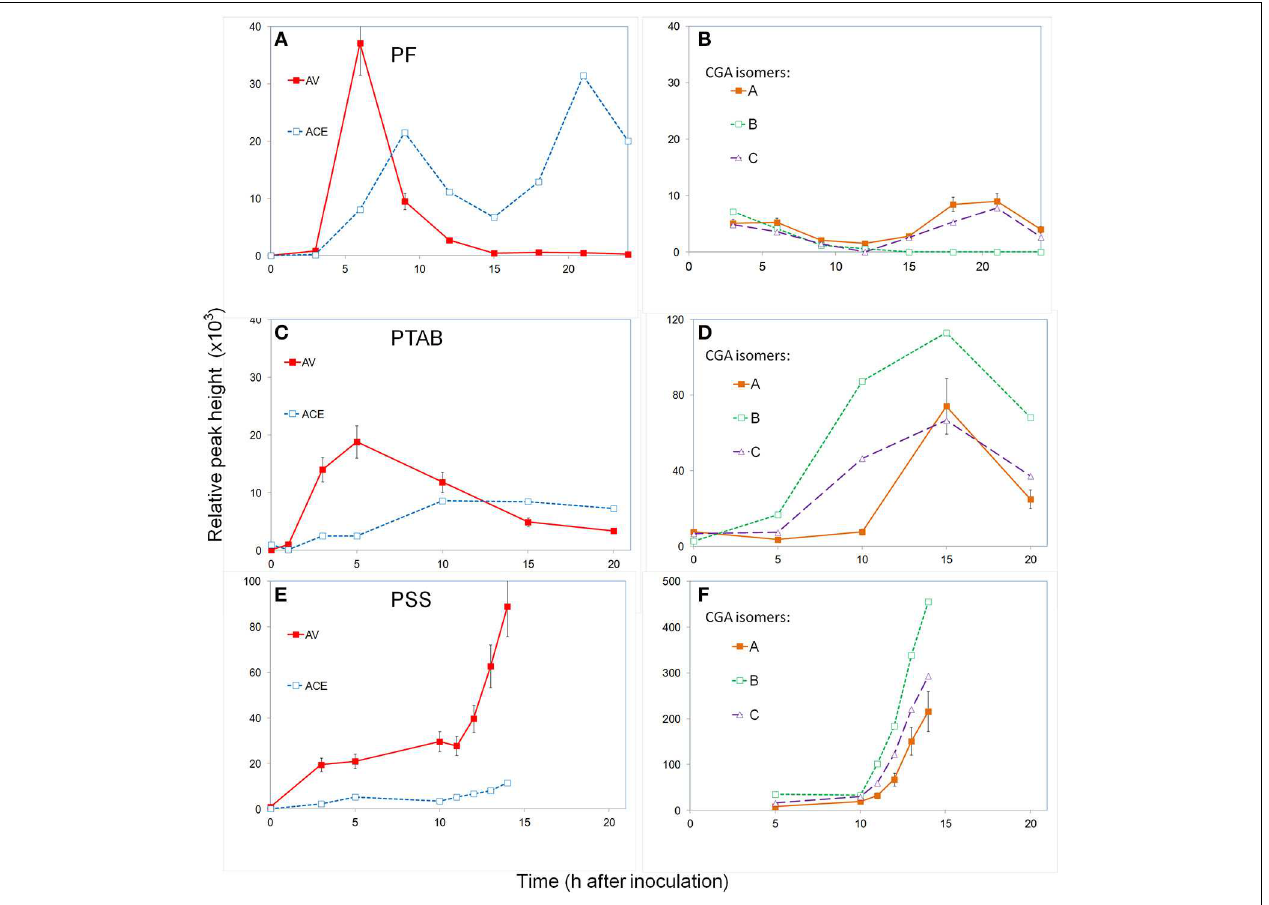
FIGURE 4 | Time course monitoring apoplast phenolics in tobacco inoculated with P. fluorescens (A,B ), P.s. tabaci (C,D), and P.s. syringae (E,F). The leaf segments were inoculated with 10 8 CFU ml − 1 and the apoplast fluid extracted periodically and analyzed for phenolic